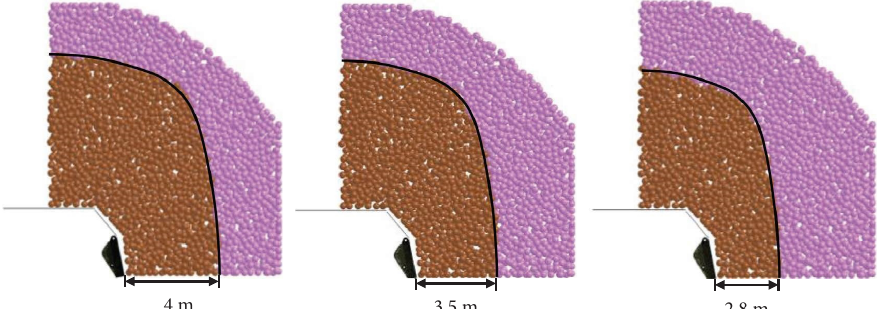
Figure 17: Coal gangue interface under three diferent coal-caving steps.